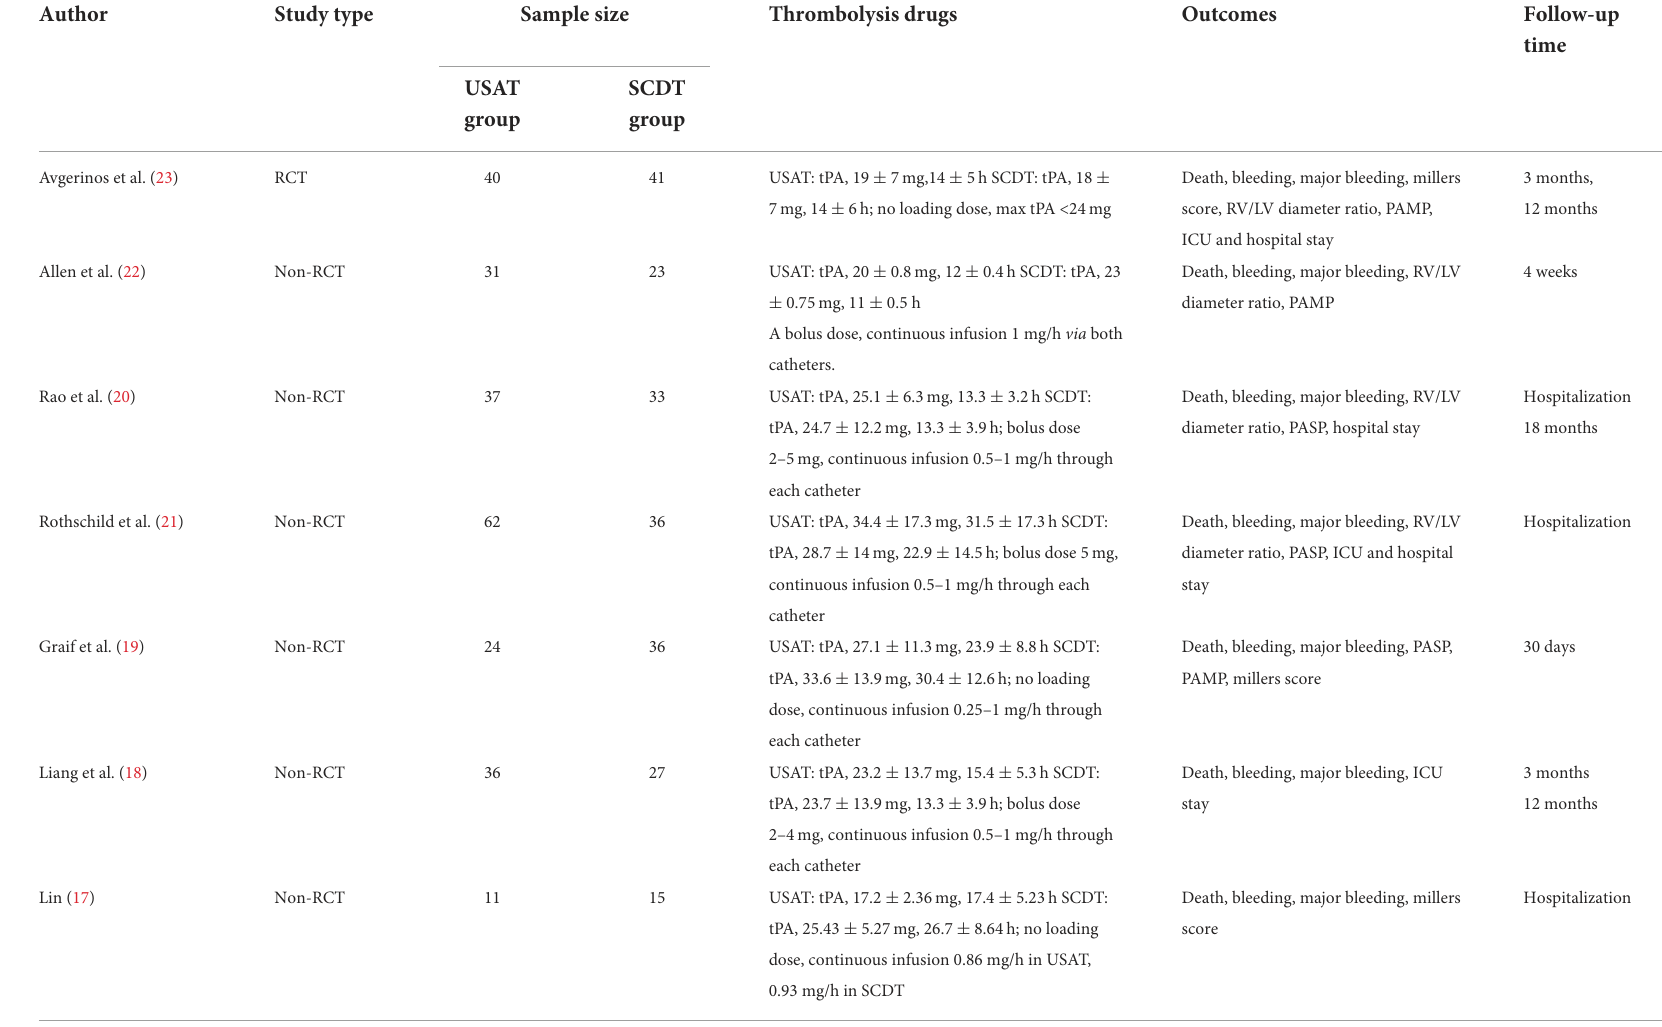
TABLE 1 Baseline and procedural